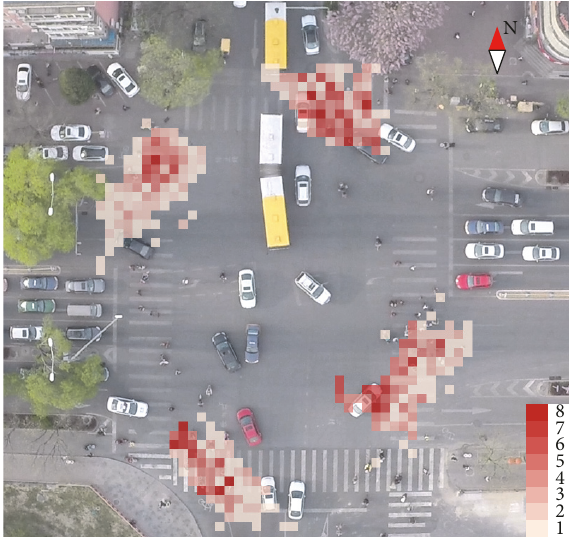
Figure 10: Spatial distribution of the number of small PETs.